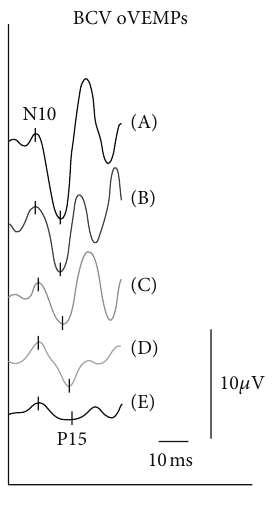
Figure 3: BCV oVEMP at 500 Hz (100dB nHL) before (A) and after intratympanic gentamicin treatment from week 1 (B) to week 2 (C), week 3 (D), and week 4 (E).